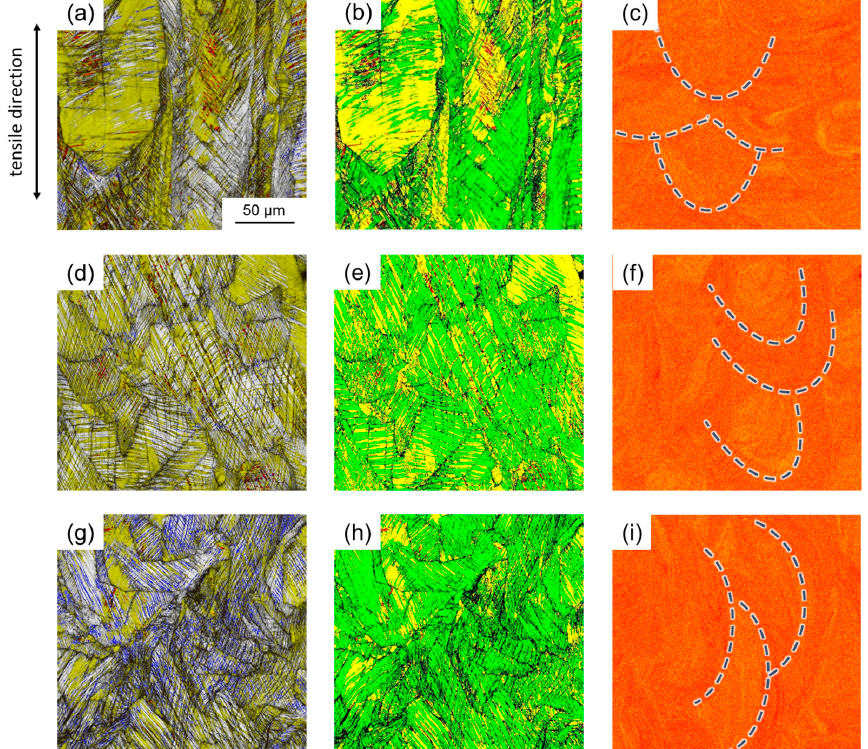
Figure 9. Microstructure of the specimens after tensile loading (up to fracture): ( a – c ) 90°; ( d – f ) 45°; ( g – i ) 0°. ( a , d , g ) are image quality EBSD maps overlain by a phase map only including hexagonal ε -martensite in yellow and tetragonal α ’-martensite in red. Blue lines indicate Σ 3 grain boundaries (60° ± 5° <111>). ( b , e , h ) are EBSD maps showing the autenite phase in green, hexagonal ε -martensite in yellow, and α ’-martensite in red. ( c , f , i ) illustrate EDX element maps of the Mn distribution. Blue dashed lines indicate the position of individual laser-melted tracks.